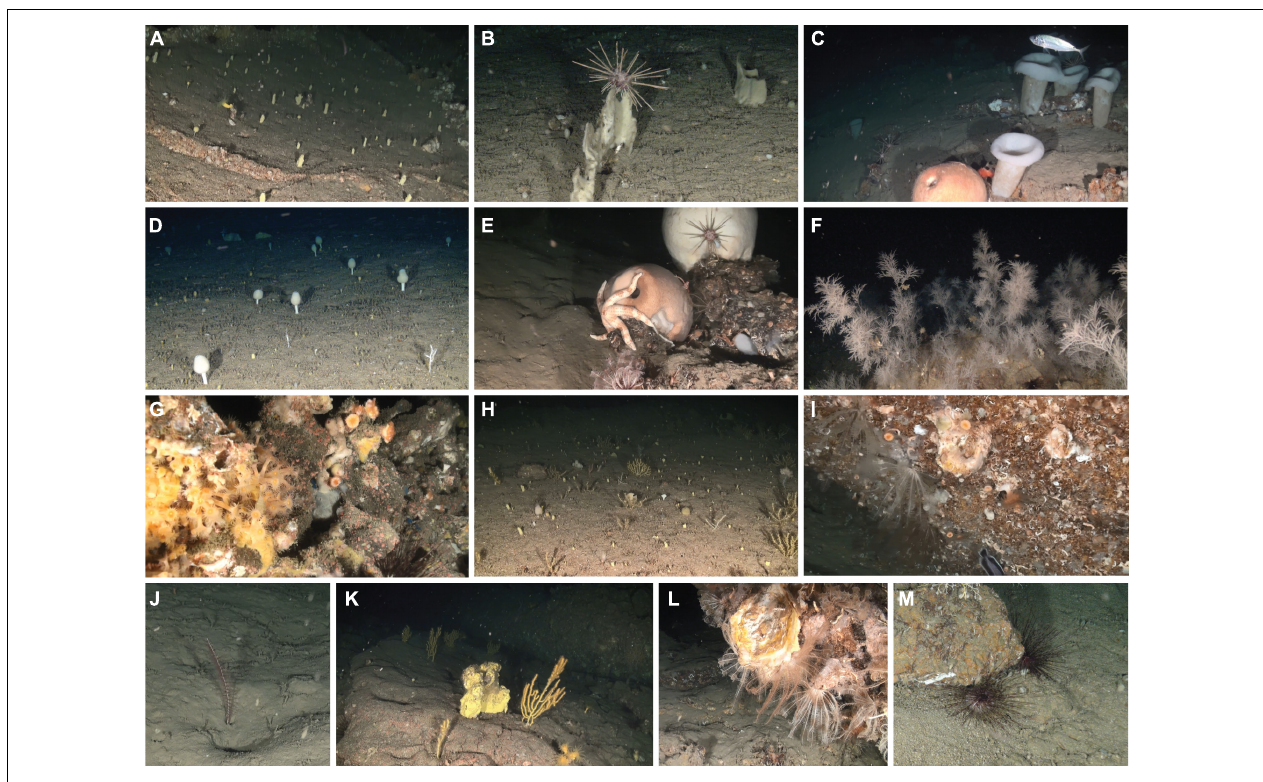
FIGURE 4 | Representative images of the 13 habitats found in the São Vicente Submarine Canyon, identified as containing features of potential conservation interest. From left to right and top to bottom: (A) Small yellow sponge aggregation; (B) Laminar sponge aggregation; (C) Asconema setubalense aggregation; (D) Artemisina transiens aggregation; (E) Geodia megastrella patches; (F) Black coral garden; (G) Mixed anthozoan and encrusting sponge communities; (H) Gorgonian gardens; (I) Cup coral field; (J) Sea pen field; (K) Mixed gorgonian and sponge gardens; (L) Crinoid beds; (M) Centrostephanus longispinus habitat. Images obtained from the surveys conducted by OCEANA in collaboration with